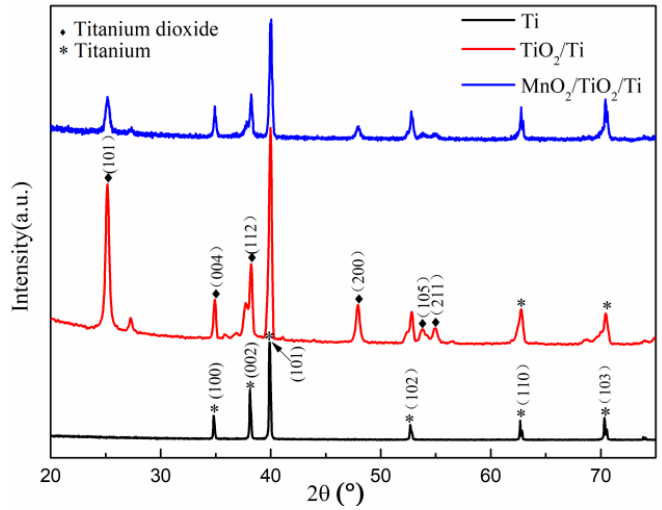
Figure 1. X-ray diffraction patterns of commercialized metal porous Ti, surface-modified TiO 2 /Ti, and MnO 2 /TiO 2 /Ti nanocomposites.